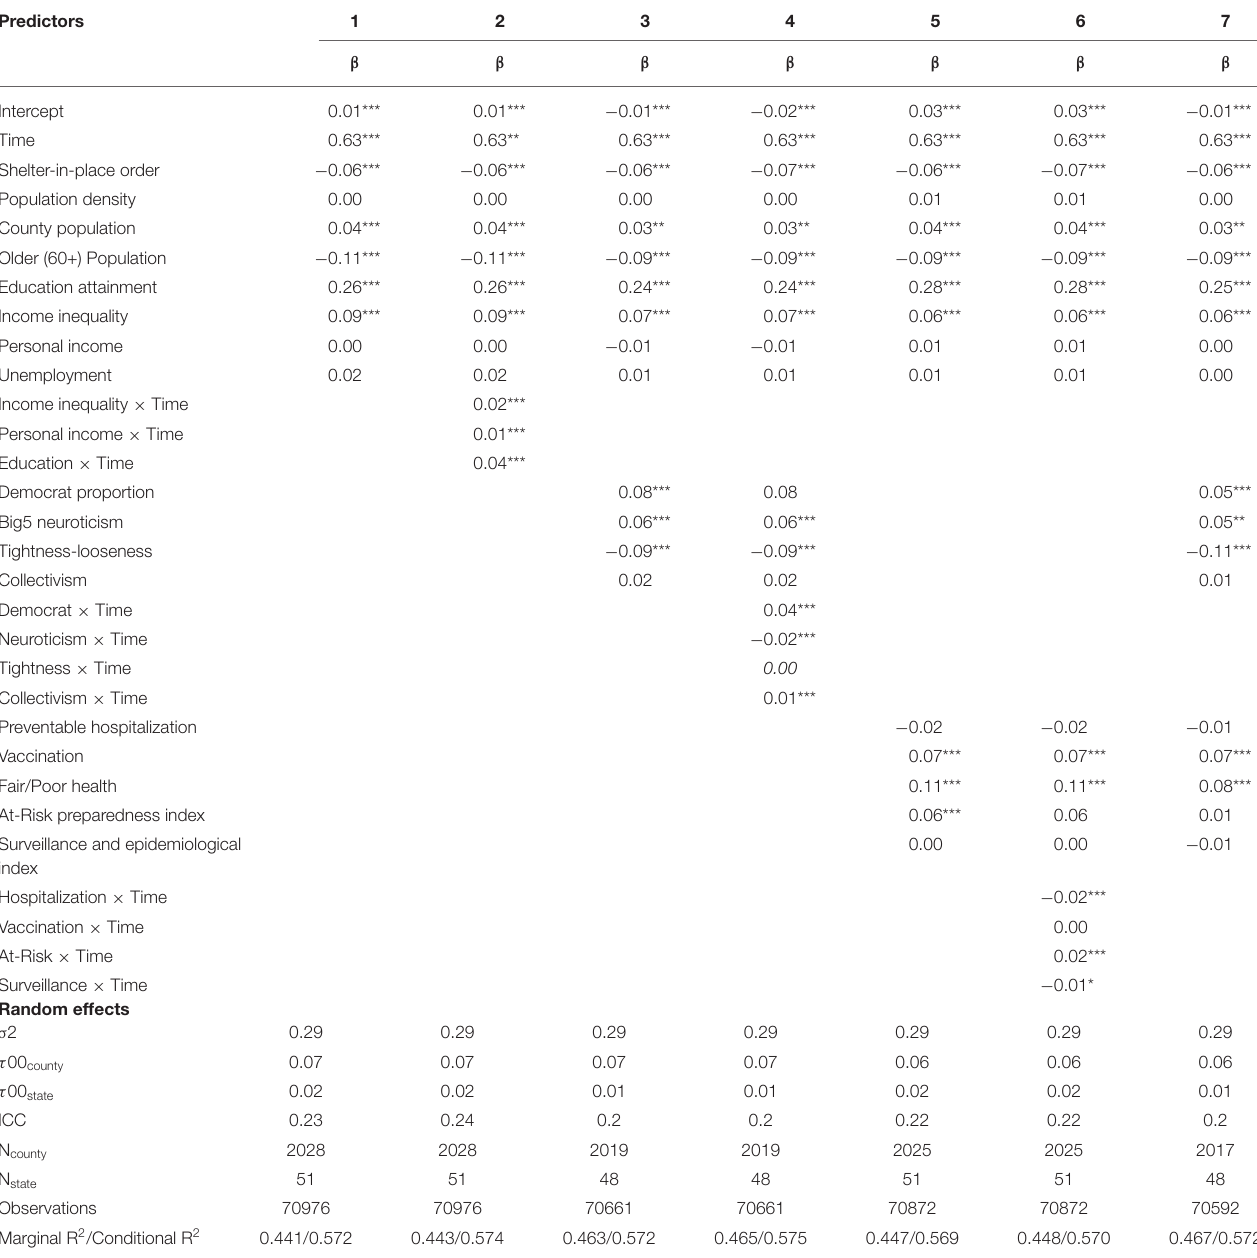
TABLE 3 | Reduction in non-essential visitation mobility (From March 8 to April 12, 2020).